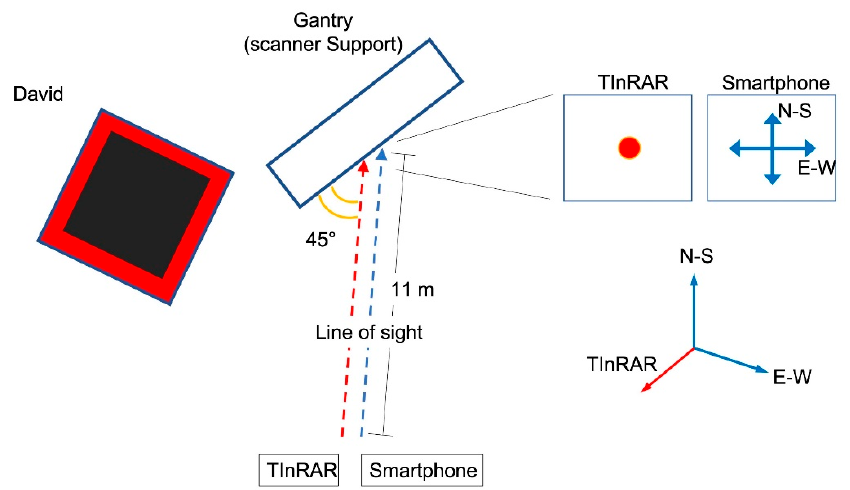
Figure 23. Geometric scheme (top-view).